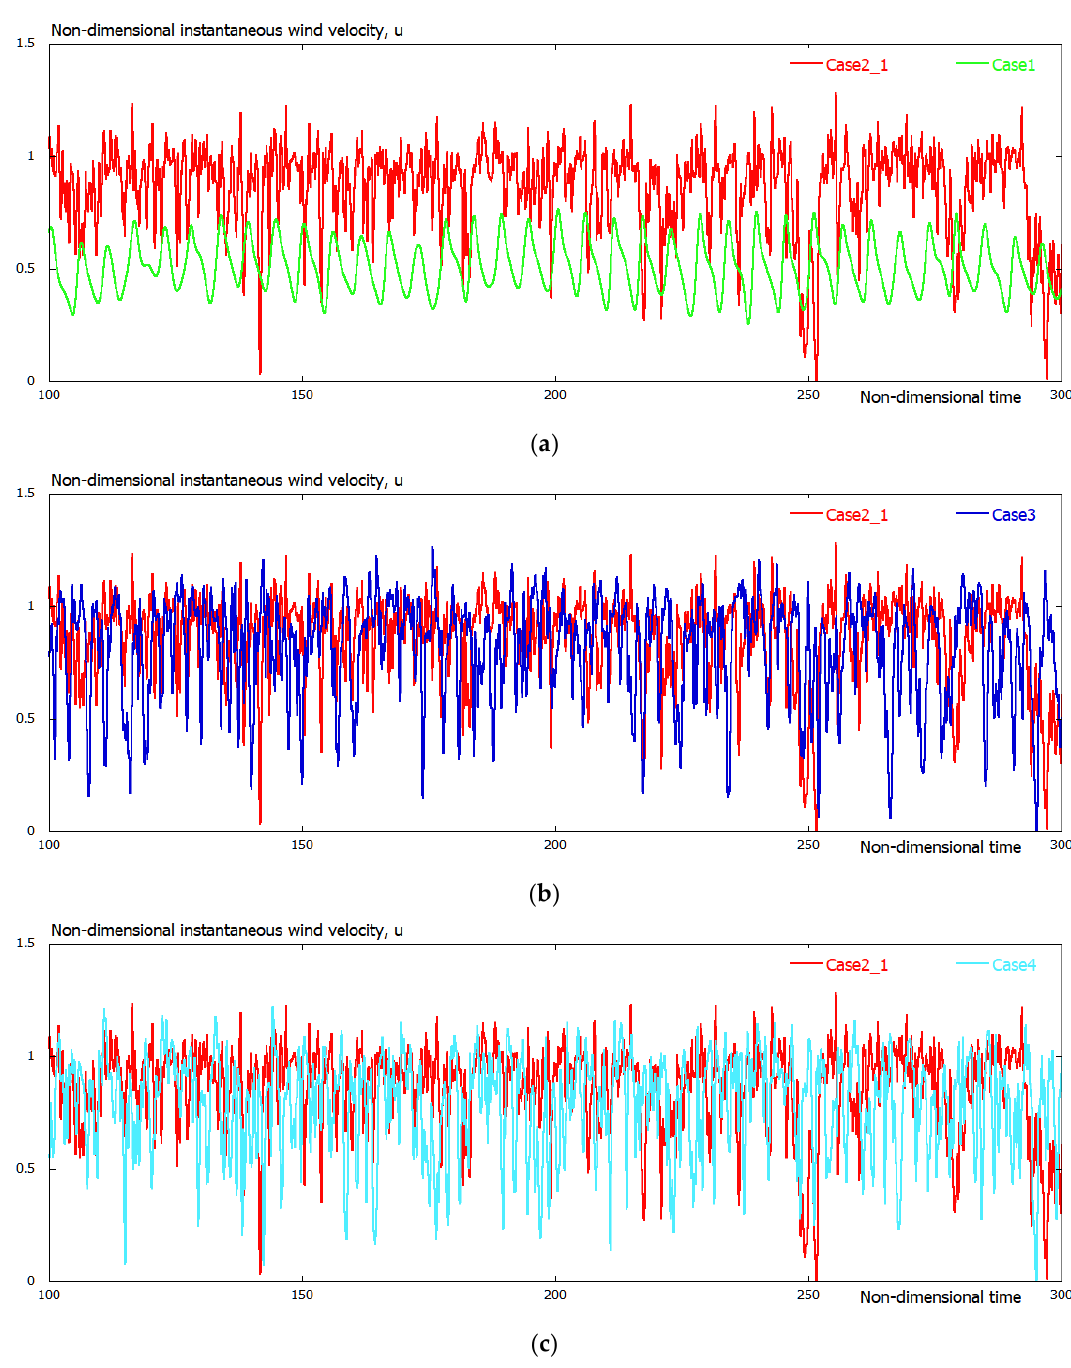
Figure 14. Comparison of temporal changes in the wind velocity component in the streamwise direction at the wind turbine hub height (78 m above the ground surface): ( a ) comparison of Case2_1 and Case1, ( b ) comparison of Case2_1 and Case3, and ( c ) Comparison of Case2_1 and Case4. The vertical and horizontal axes are normalized with the two characteristic scales ( U in and h ) shown in Figure 11.